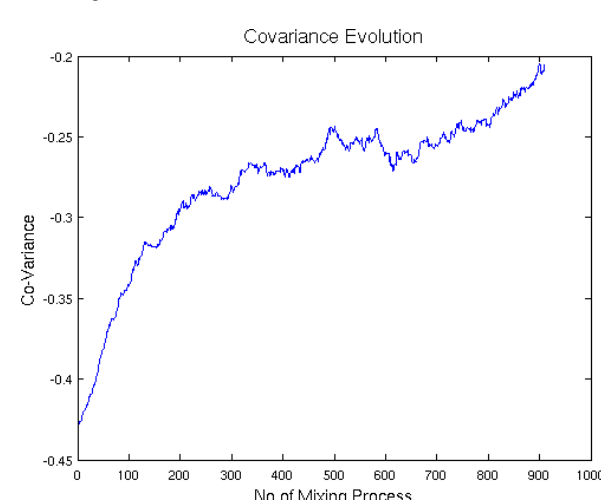
Fig. 4 Principle of covariance based mixing: As the blue particles are perpendicular to the reference slope (dashed line), they mix more rapidly as the brown particicles, which are more in-line to the reference slope (mixing intensity indicated by arrow length)